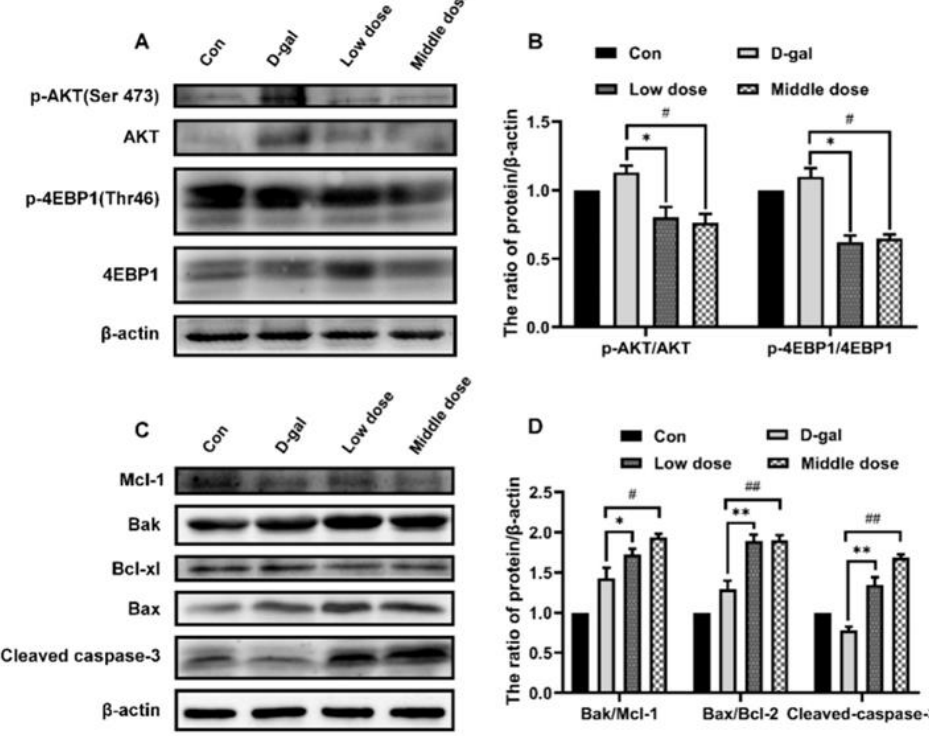
Figure 8. Anthocyanin decreased the activity of PI3K/AKT/mTOR and increased apoptosis in mice lenses induced by D-galactose. ( A , B ) The expression of p-AKT/AKT, p-4EBP1/4EBP1 were measured using western blot. ( C , D ) The expression of Bcl-2 family proteins and Cleaved-caspase-3 were measured using western blot. Data are presented as mean ± SD, n = 3. * p < 0.05, ** p < 0.01, # p < 0.05, ## p < 0.01.